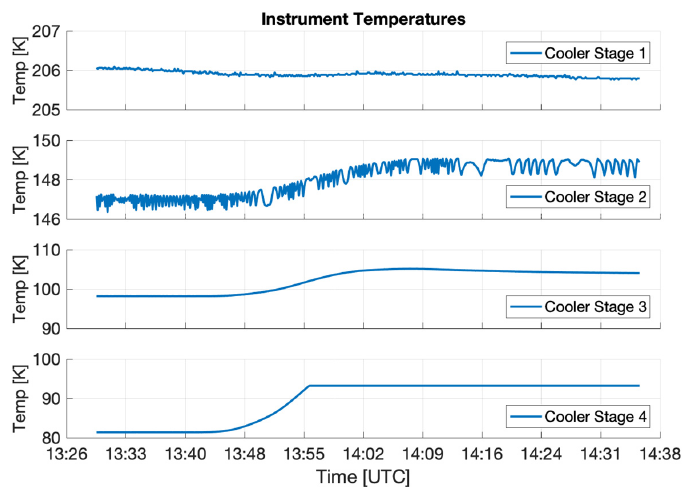
Figure 10. CrIS cooler stage temperatures during the pitch maneuver for NOAA-20. The maneuver began at approximately 13:34 UTC and ended at approximately 14:18 UTC. The cooler stage four temperature sensor was out of range shortly after 13:56 UTC. temperature sensor was out of range shortly after 13:56